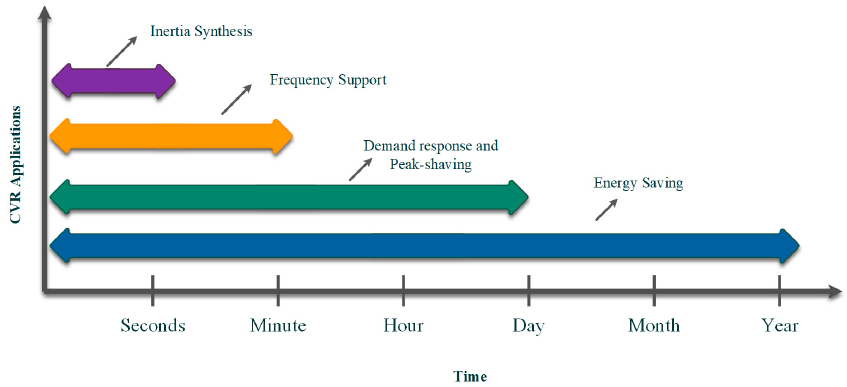
Figure 2. CVR applications in modern PE-based grids at different time scales. Table 1. Experimental results of the CVR effect on different demand types